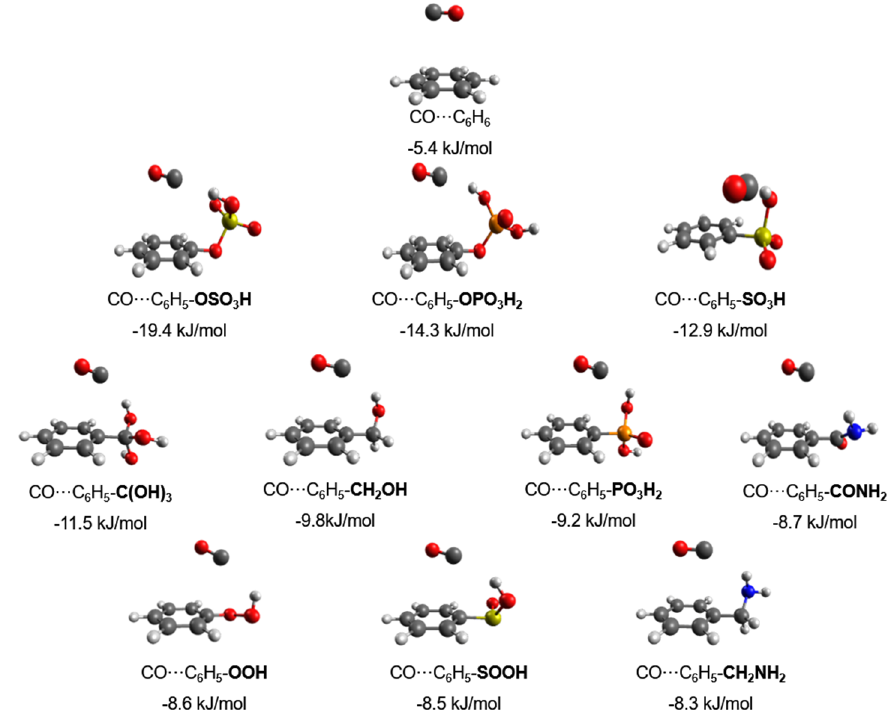
Figure 1. MP2/6-311++G** optimized geometries for the 10 best-performing FGs .